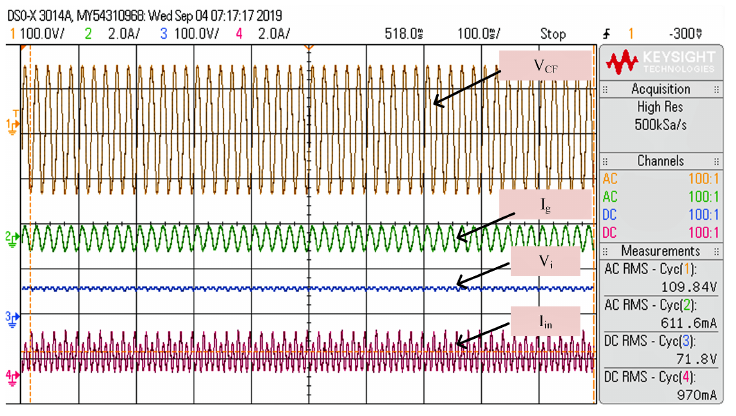
and I L during P max = 70 W. P N